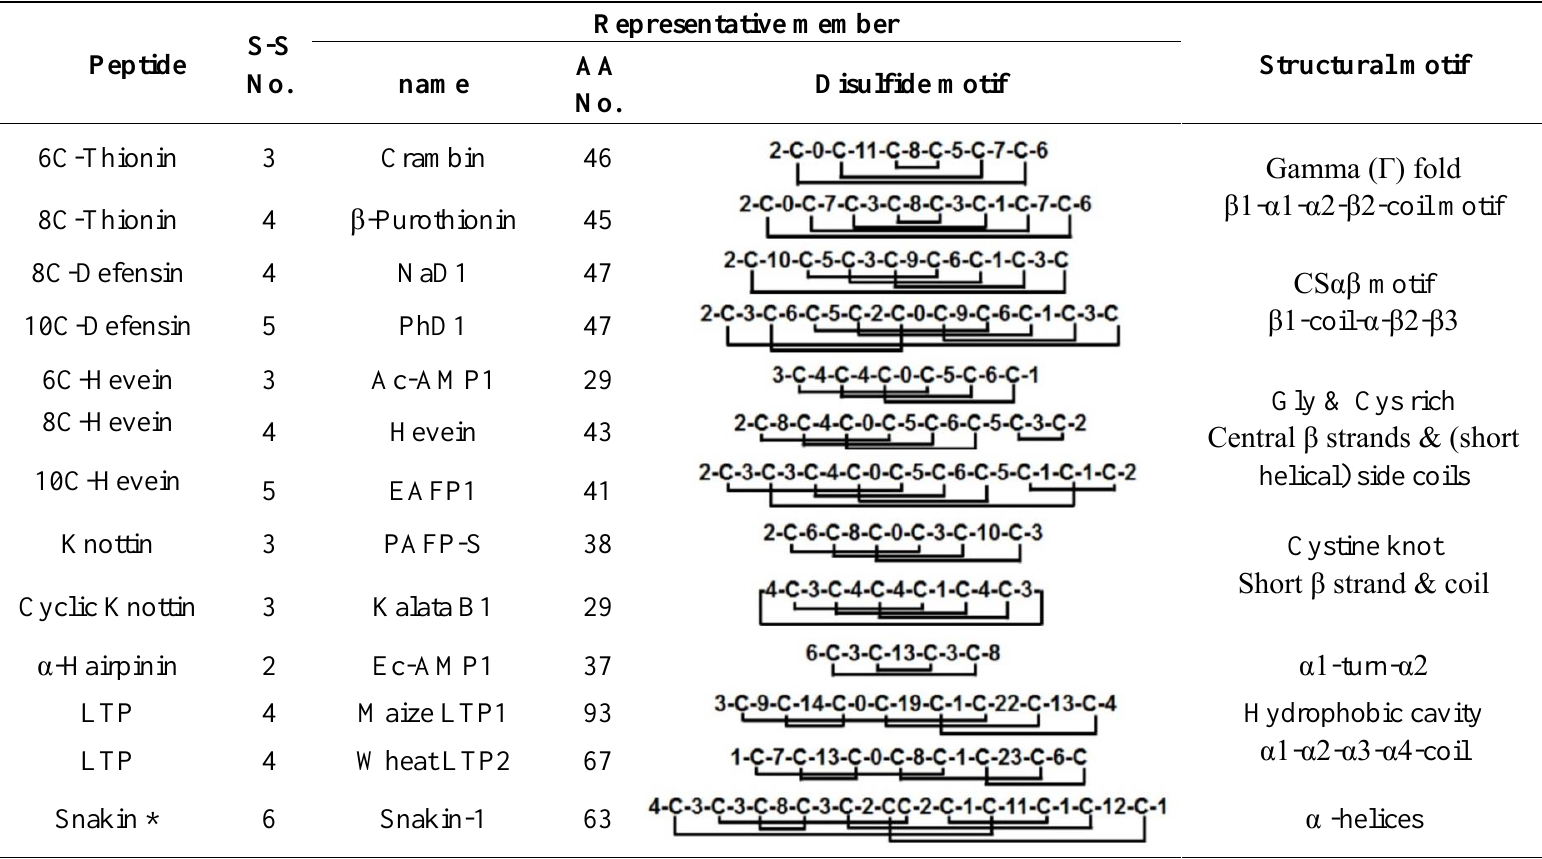
Table 1. Major families of plant